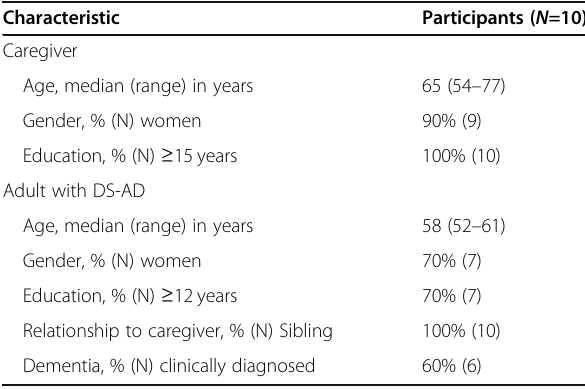
Table 2 Characteristics of the person with DS and their